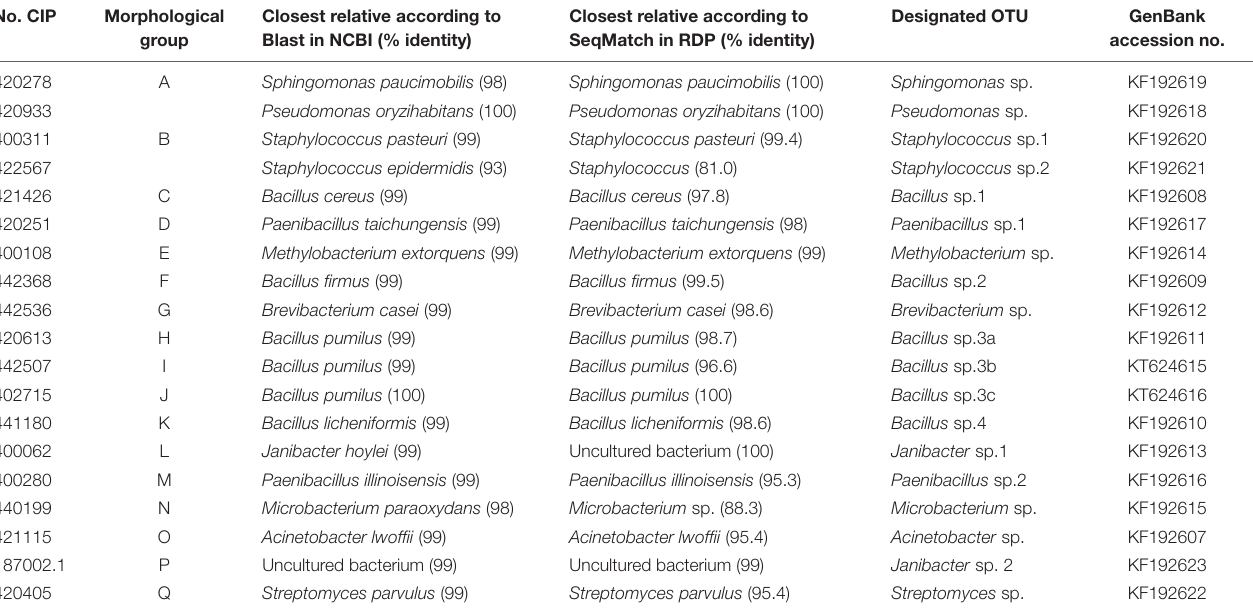
TABLE 2 | Identification of isolated bacteria based on sequence similarity of partial 16S sequences to the NCBI and RDP databases. No. CIP Morphological Closest relative according to Closest relative according to group Blast in NCBI (% identity) SeqMatch in RDP (%